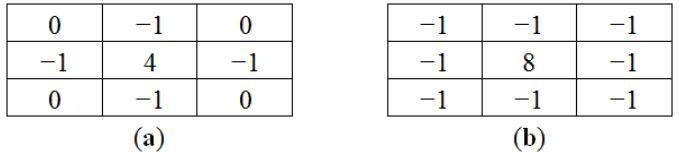
Figure 6. Laplacian filter. ( a ) 4-neighbor; ( b ) 8-neighbor.